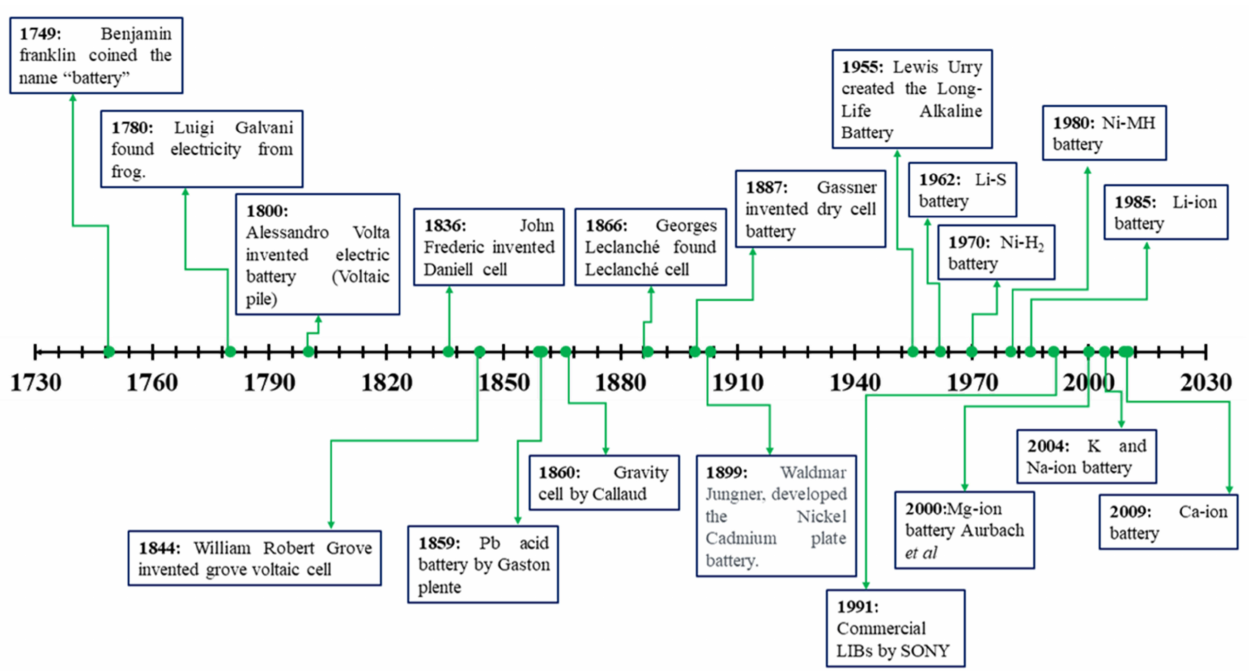
Figure 4. Timeline of battery development from 1730 to